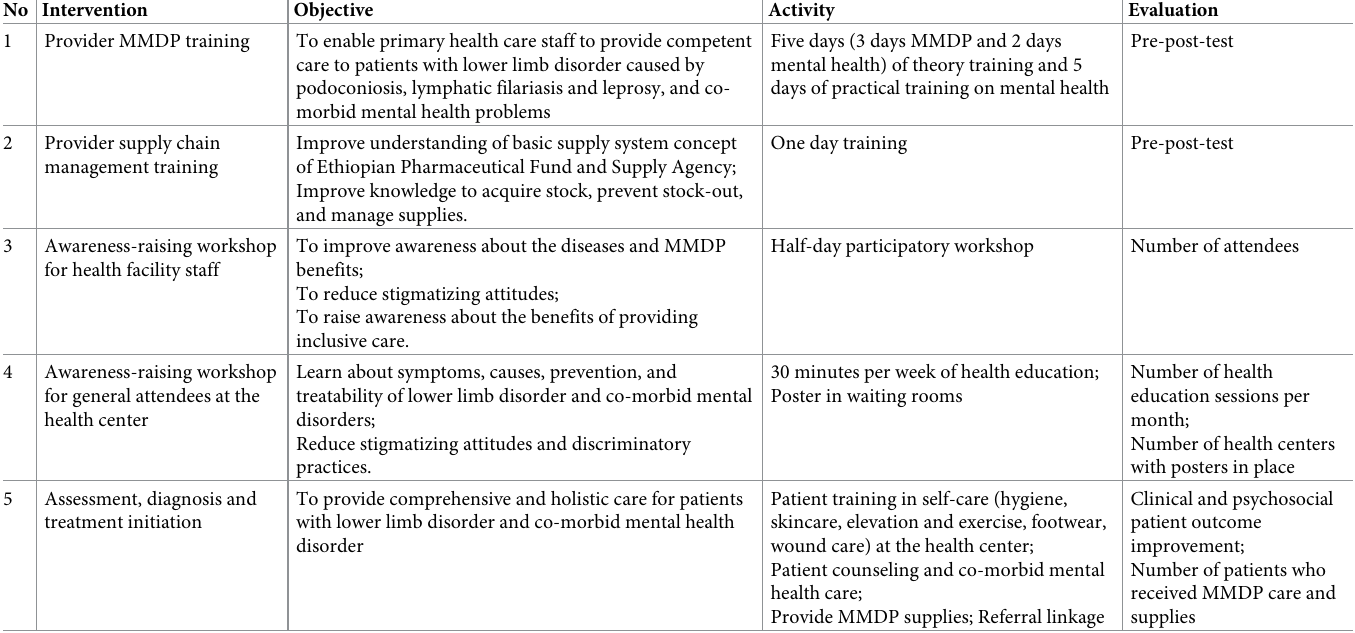
Table 2. Health Facility